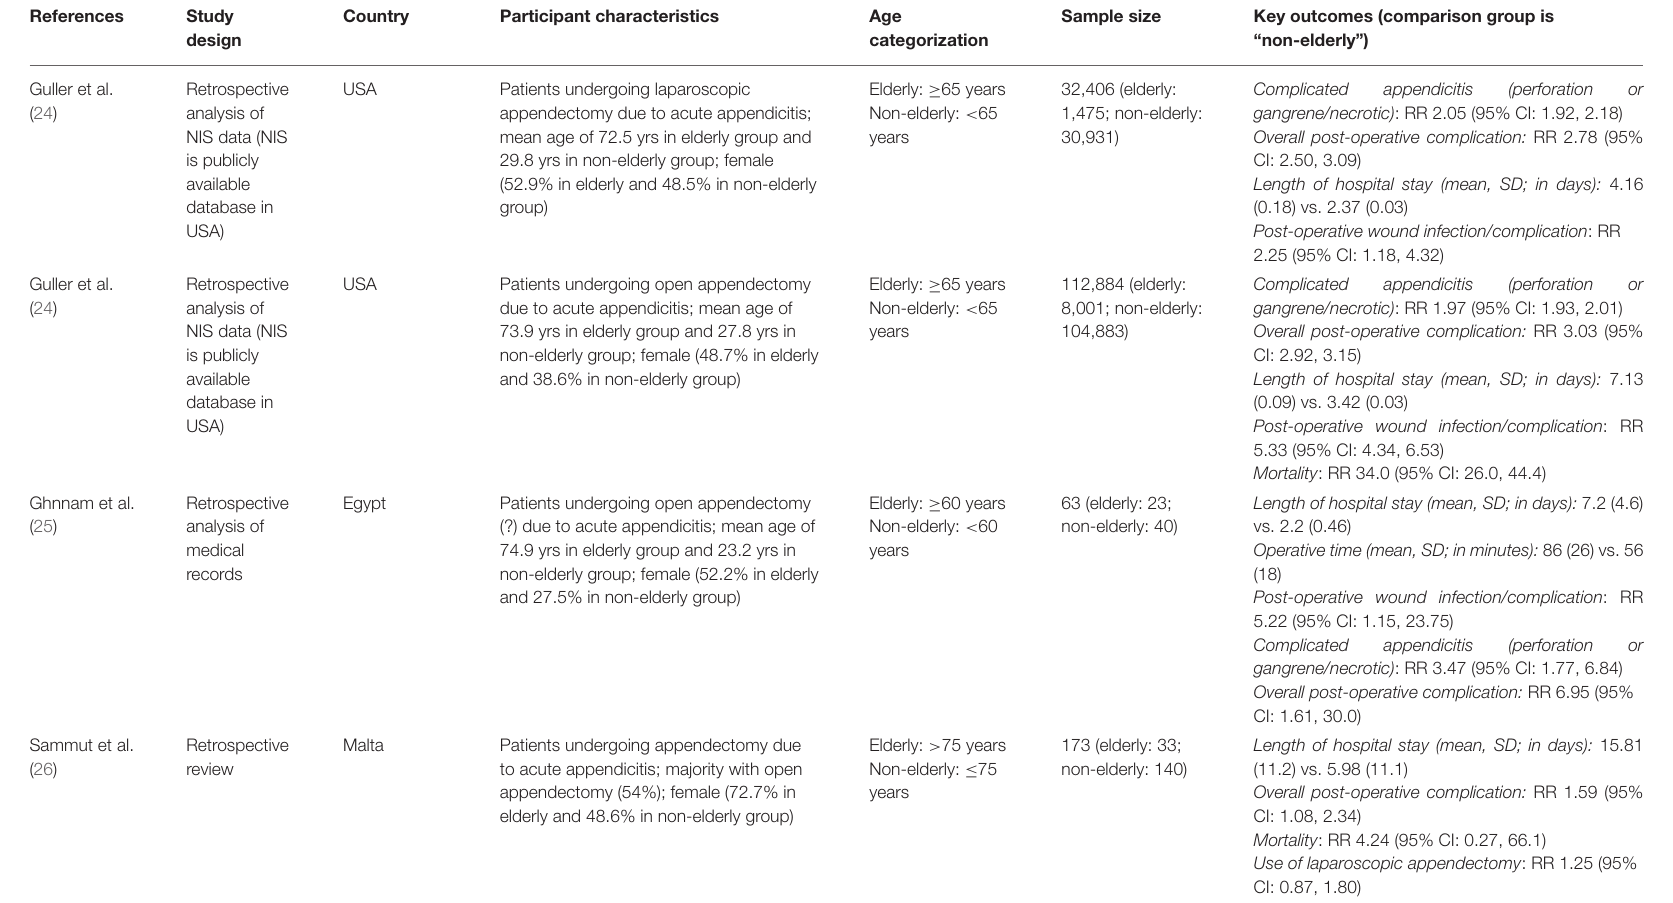
Key outcomes (comparison group is